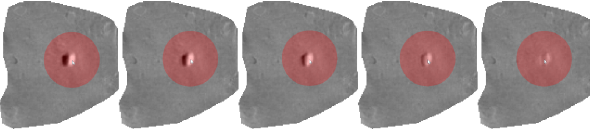
Fig. 3 Adjustment tool. The user drags the content to the correct location in texture space. For each mouse move event, real-time optimization is triggered and the result is updated. The radius of influence (i.e., the affected region) is marked in